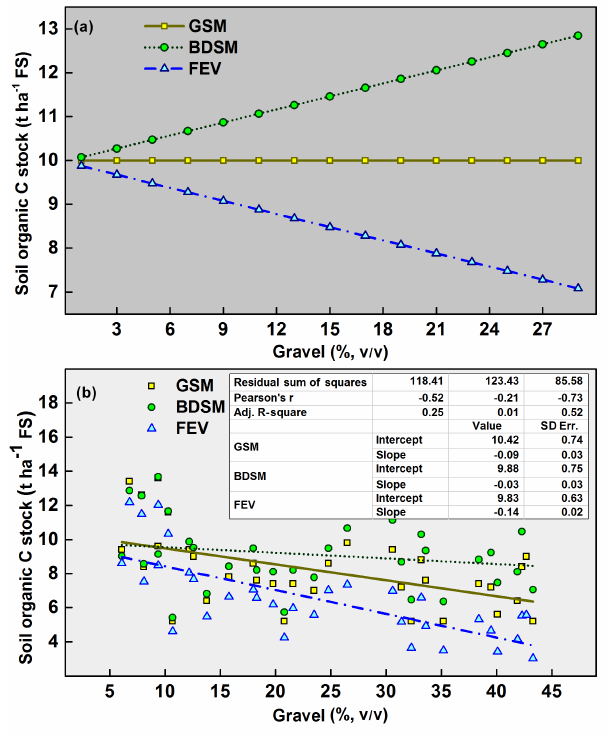
Figure 2. Soil organic C stocks in relation to different proportions of gravel content ( v/v ) under (a) hypothetical calculations using generalized soil mass of 2.0 millionkg furrow soil with 0.5% soil organic carbon and (b) observations using field soil samples. GSM is the generalized soil mass of 2.0 × 10 6 kg furrow soil, BDSM is the bulk-density-based soil mass and FEV is the fine earth volume. Figure 2a is adapted from Nagaraja and Srinivasamurthy